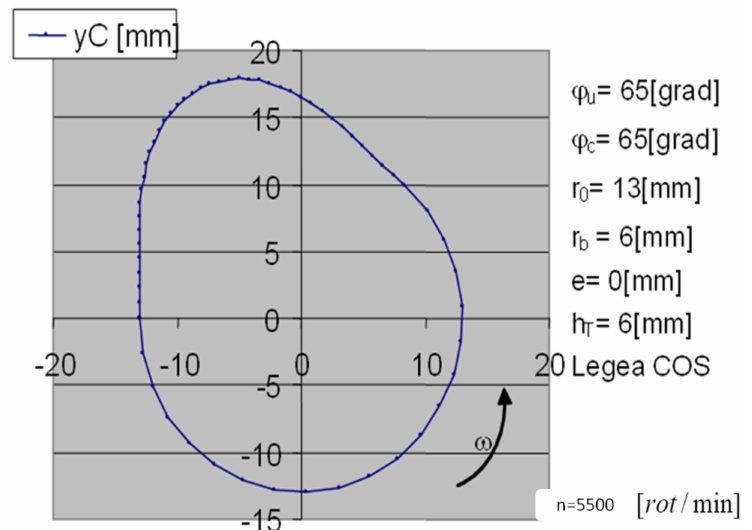
Figure 15. Cam profile at module B. COSINE law, n = 5500 [rot/min] ϕ u = 65 [degree], r 0 = 13 [mm], r b = 6 [mm], h T = 6 [mm].